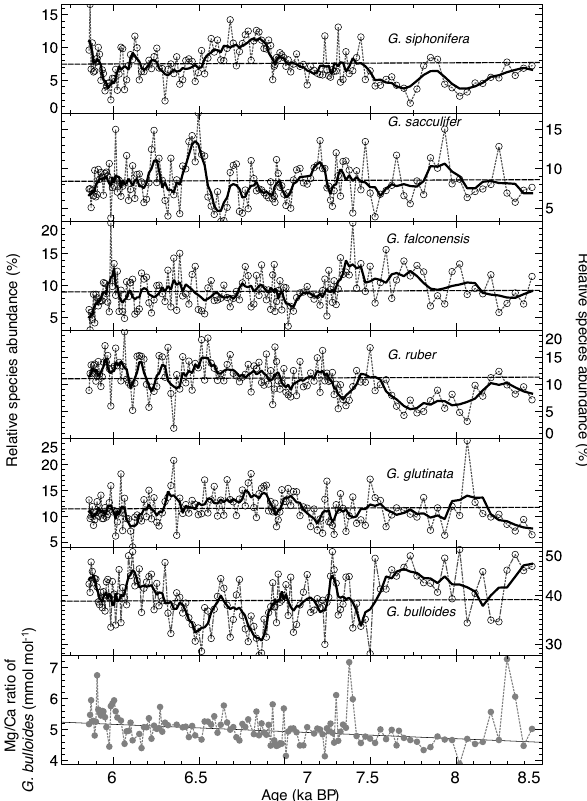
Figure 4. Time series of the six most common planktic foraminiferal species (>5% average abundance) and Mg / Ca mea- surements of G. bulloides from the studied interval in core SL163. Dashed lines are the real data; thick solid lines give the 3pt running